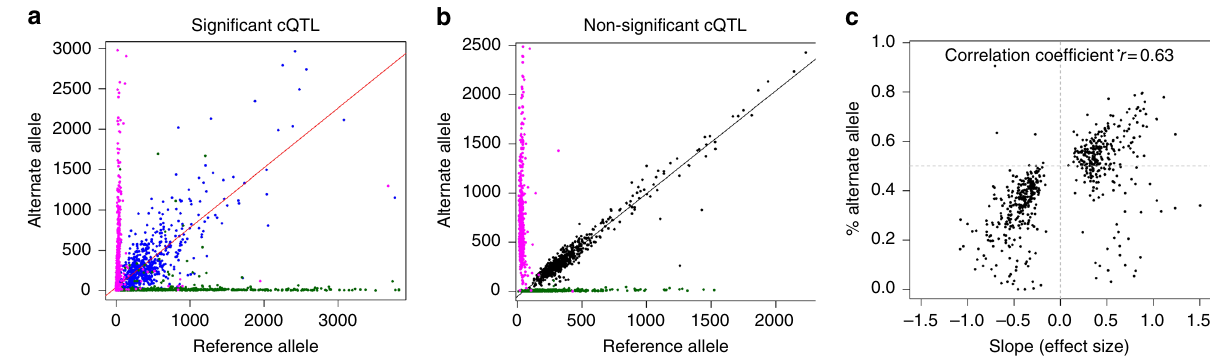
Fig. 5 Heterozygous individuals for cQTLs display allele bias. a Allele counts across cQTLs for individuals homozygous for reference alleles (green), homozygous for alternative alleles (magenta), or heterozygous for cQTL variants (blue). b Same as a , but for non-signi fi cant cQTLs. c For individuals heterozygous for cQTLs, we determined the % of each cQTL that correlated to the alternate allele ( y -axis) and compared those values to the cQTL effect